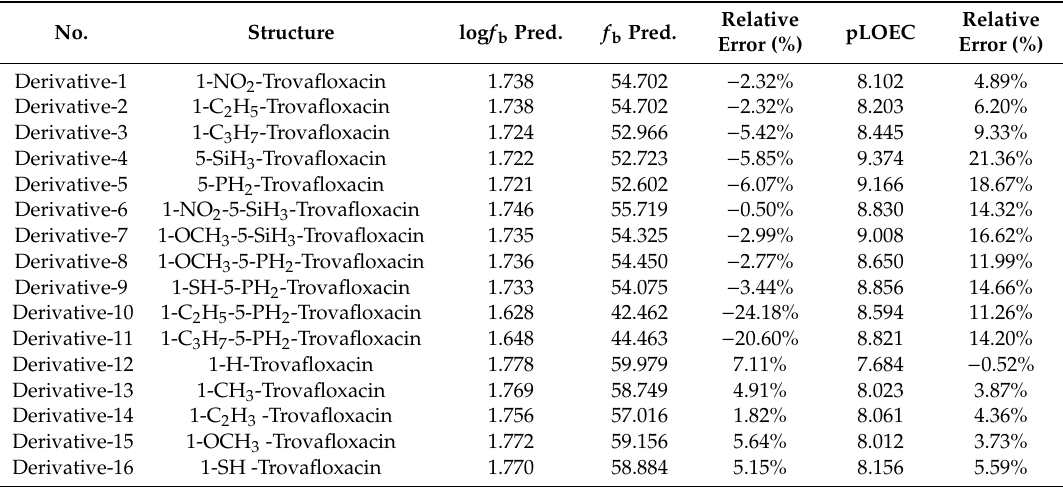
Table 2. Predicted results of log f b and pLOEC of TRO